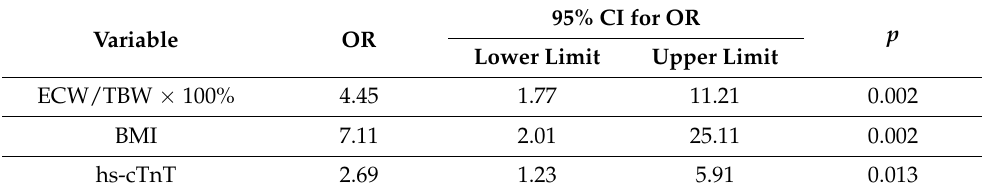
Table 5. Multivariate analysis—stepwise logistic